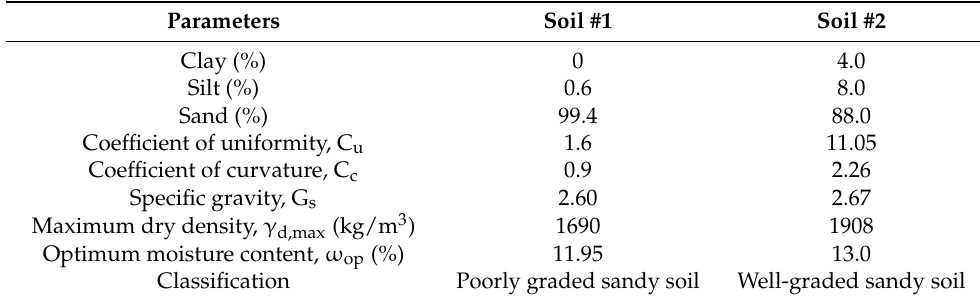
Table 1. Soil #1 and Soil #2